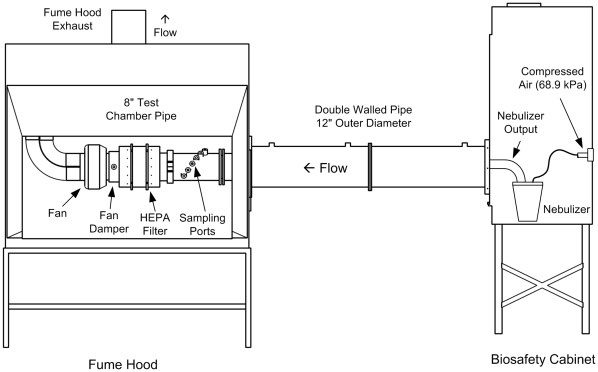
Schematic diagram of single-pass aerosol chamber with HEART nebulizer.Single-pass aerosol chamber set up used for nebulization and collection of aerosolized human cytokines. 2010©-The MITRE Corporation Approved for Public Release: 10–1260. Distribution Unlimited.